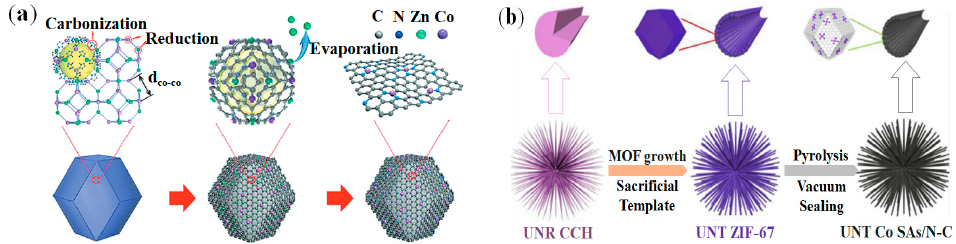
Figure 4. Synthesis methods of Co-SACs: ( a ) Synthesis from bimetallic Zn/Co MOF. Adapted with permission from Ref. [75]. Copyright 2016 John Wiley and Sons. ( b ) Synthesis from UNR CCH. Adapted with permission from Ref. [81]. Copyright 2019 Elsevier.